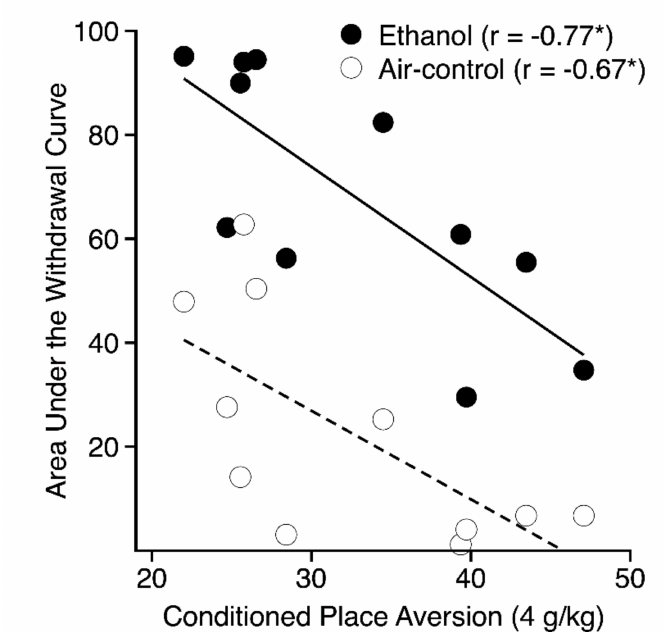
Figure 8. Scatterplot showing the genetic correlations between ethanol withdrawal expressed as uncorrected area under the withdrawal curve [10] (y-axis) and conditioned place aversion indexed as mean percent time on the ethanol-paired floor (x-axis) for the 4-g / kg conditioned place aversion groups. The open symbols and dashed lines represent mice in the air-control groups, whereas the closed symbols and solid lines represent mice in the chronic ethanol withdrawal groups. Each point represents the strain mean scores for both